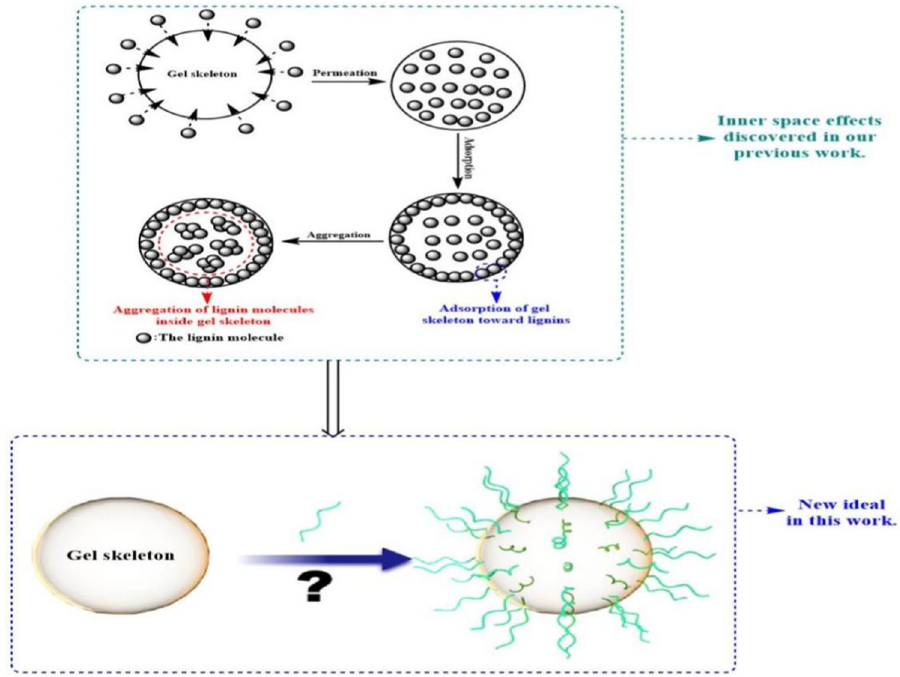
Fig. 1 A diagram for proposing new ideal in this work based on our previous original